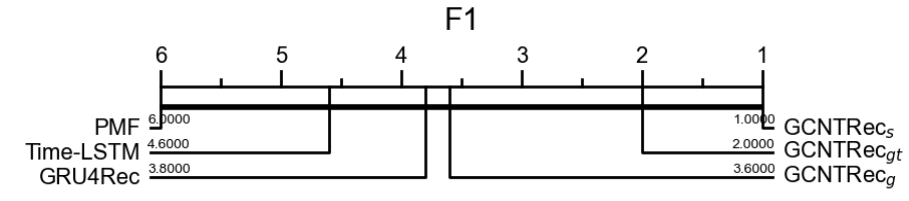
Figure 4. Critical difference diagrams for precision.